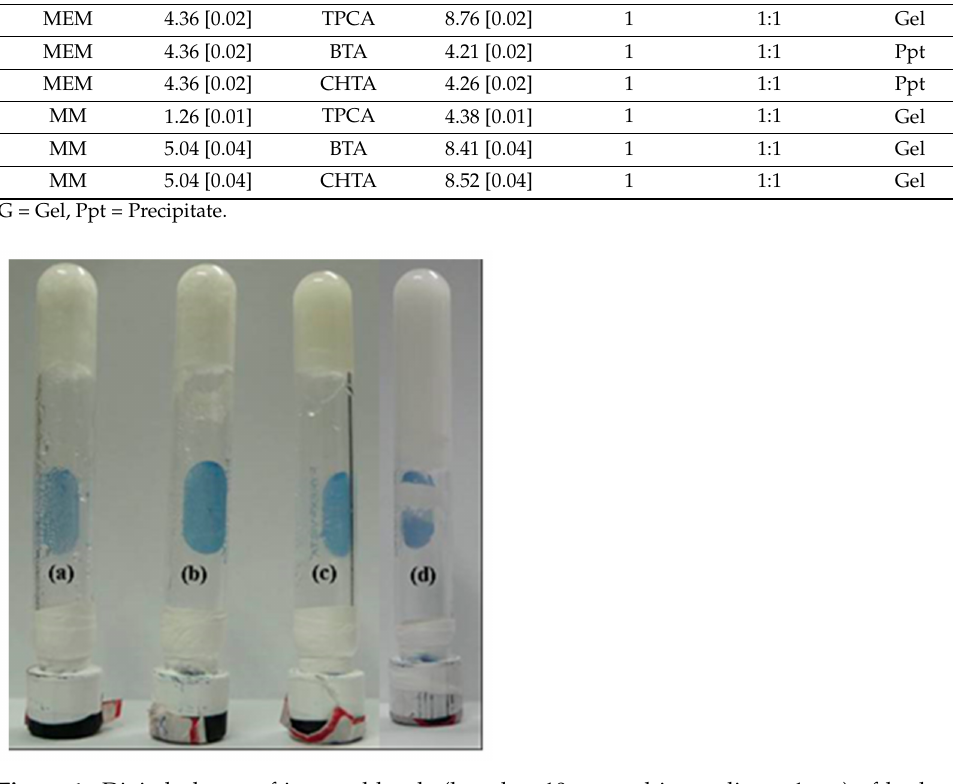
Figure 1. Digital photos of inverted bottle (length = 10 cm and inner dia. = 1 cm) of hydrogel, ( a ) MEM:TPCA = 1:1, ( b ) MM:TPCA = 1:1, ( c ) MM:BTA = 1:1 and ( d ) MM:CHTA =